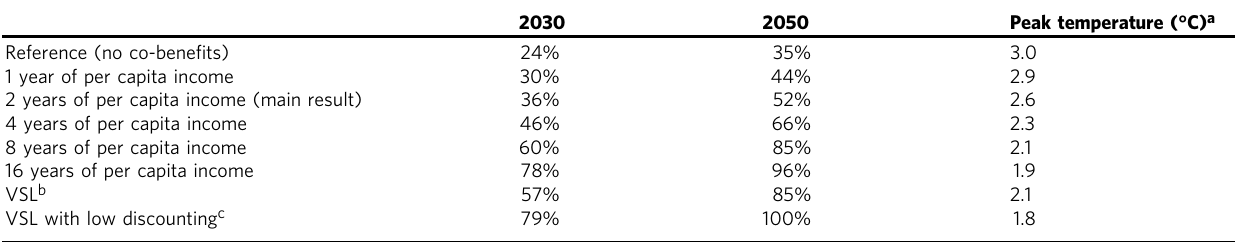
Table 2 Monetizing